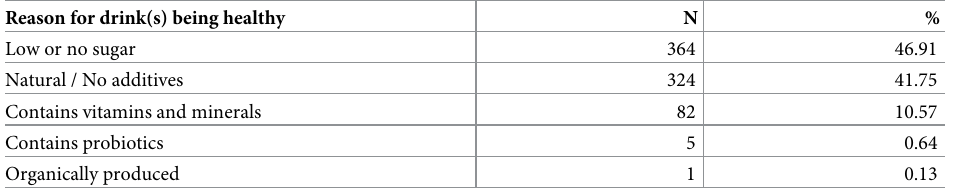
Table 3. Reasons consumers consider drink(s) as healthy.